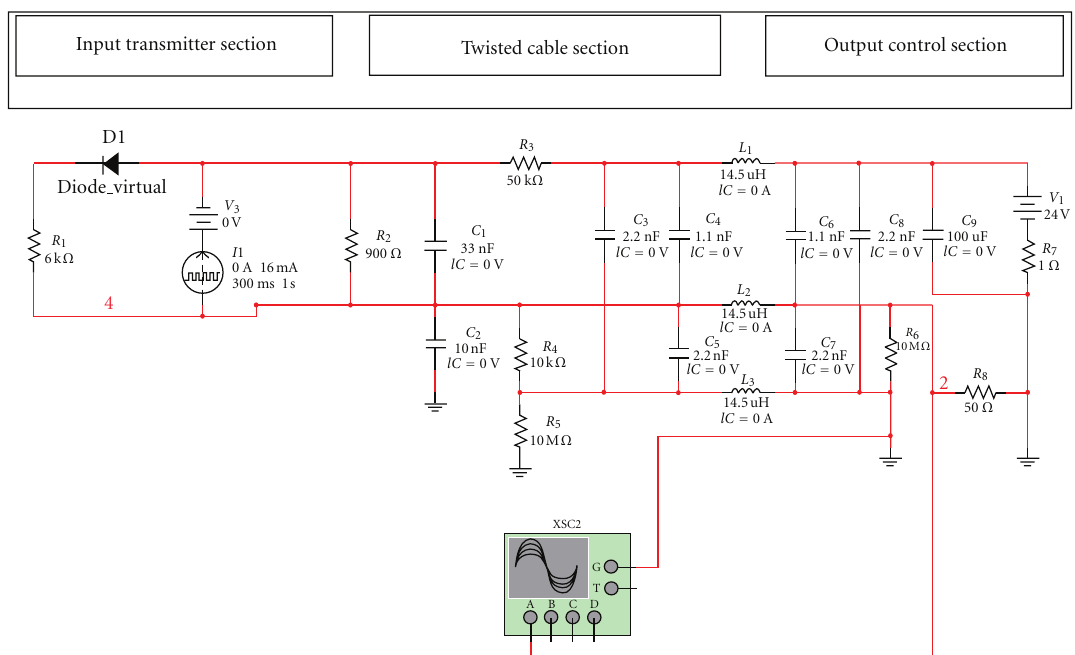
Figure 6: Overall circuit model modified to run in the MultiSIM code.